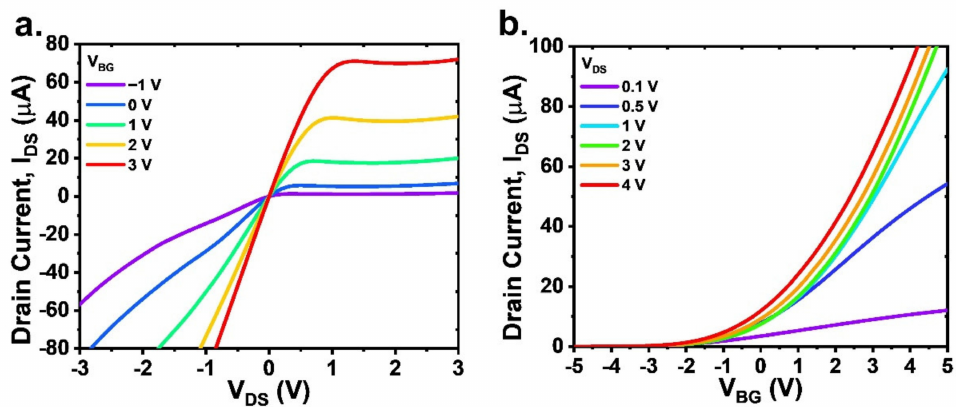
Figure 3. Electrical characteristics of NW-FET ( a ) transfer characteristics (I DS –V DS ) at various V BG from − 1 V to 3 V and ( b ) output characteristics (I DS –V BG ) at various V DS from 0.1 V to 4 V.